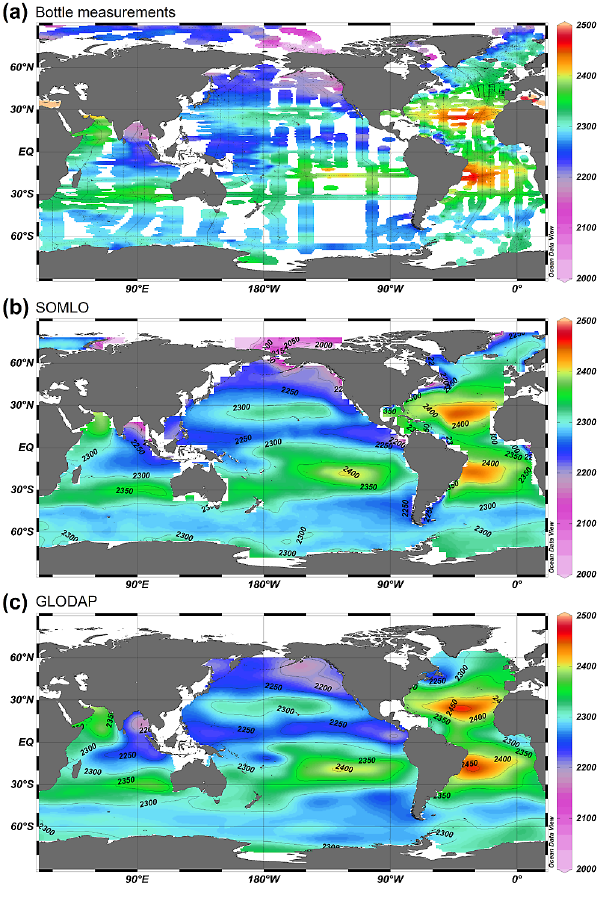
Fig. 19. Global distributions of (a) bottle C T measurements cor- rected to the year 2000 (b) annual-mean SOMLO C T predictions for the nominal year 2000 (c) GLODAP-v1.1 ocean surface C T dis- tribution of Key et al. (2004).